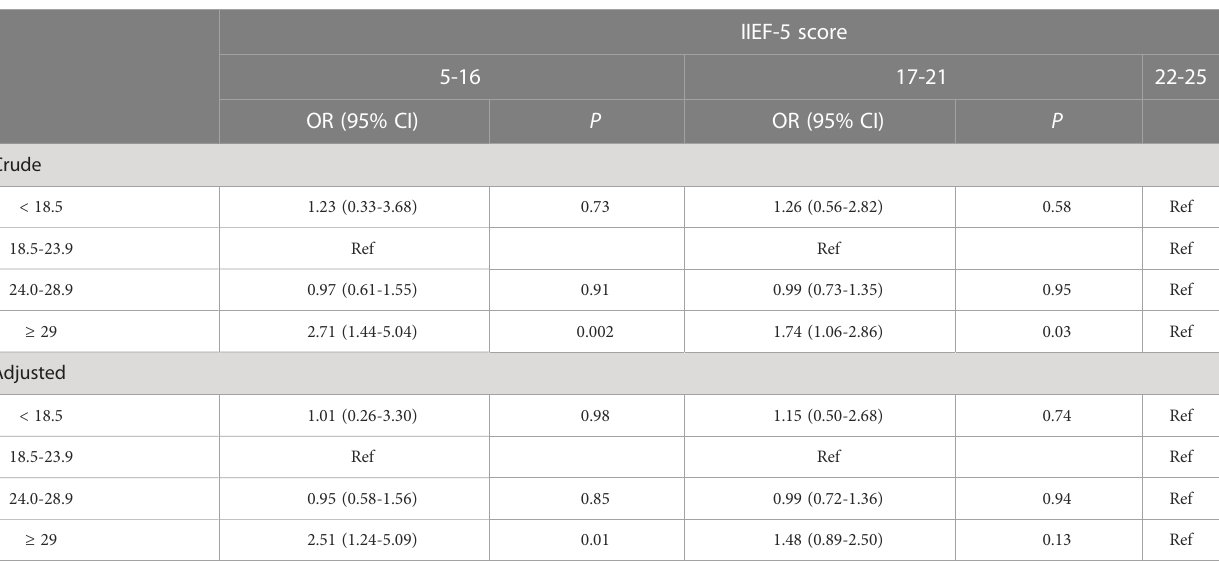
TABLE 5 Logistic regression for the association between BMI and ED